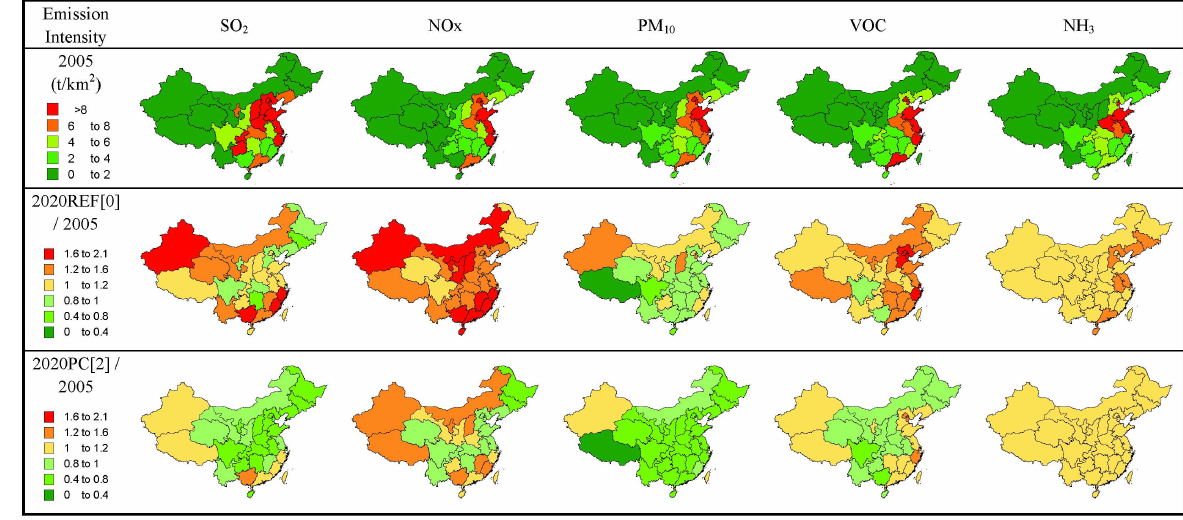
Fig. 3. Emission intensities of air pollutants in 2005 and 2020.